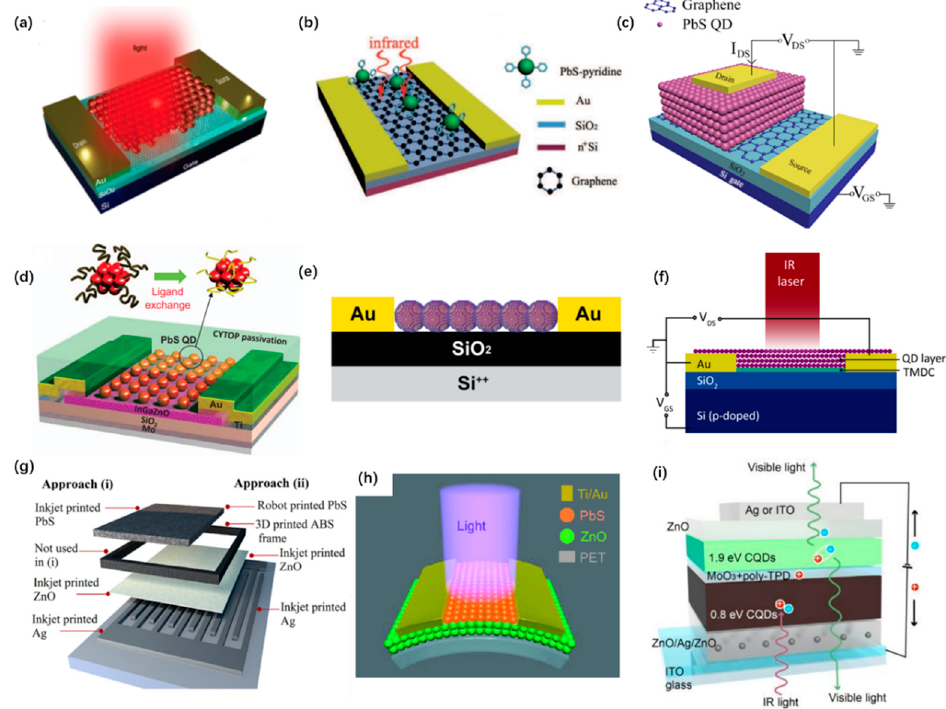
Figure 3. ( a ) Schematic diagram of graphene QD hybrid phototransistor; graphene sheets are de-